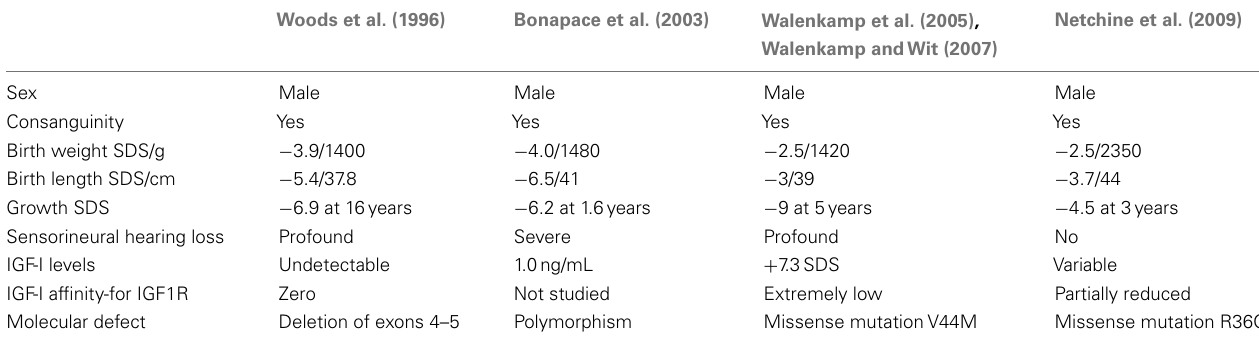
Table 1 | Reported cases with homozygous mutations of the IGF1